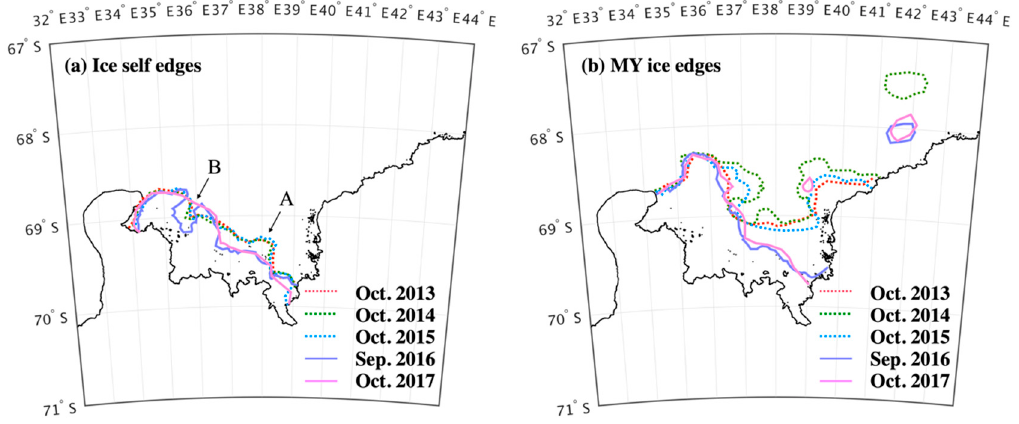
Figure 10. The ice edge of ( a ) the ice shelf and ( b ) MY ice in Lützow-Holm Bay derived from the ice classification algorithm. Bold black lines show the coastline.